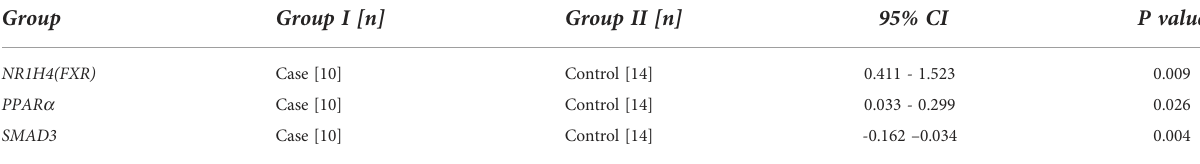
TABLE 5 PCR results(Wilcoxon rank sum test).